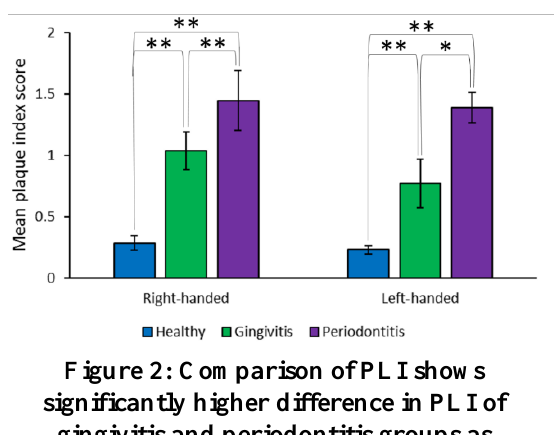
Figure 2: Comparison of PLI shows significantly higher difference in PLI of gingivitis and periodontitis groups as compared to healthy group in right- and left- handed individuals. *=P≤0.05, **=P≤0.001.